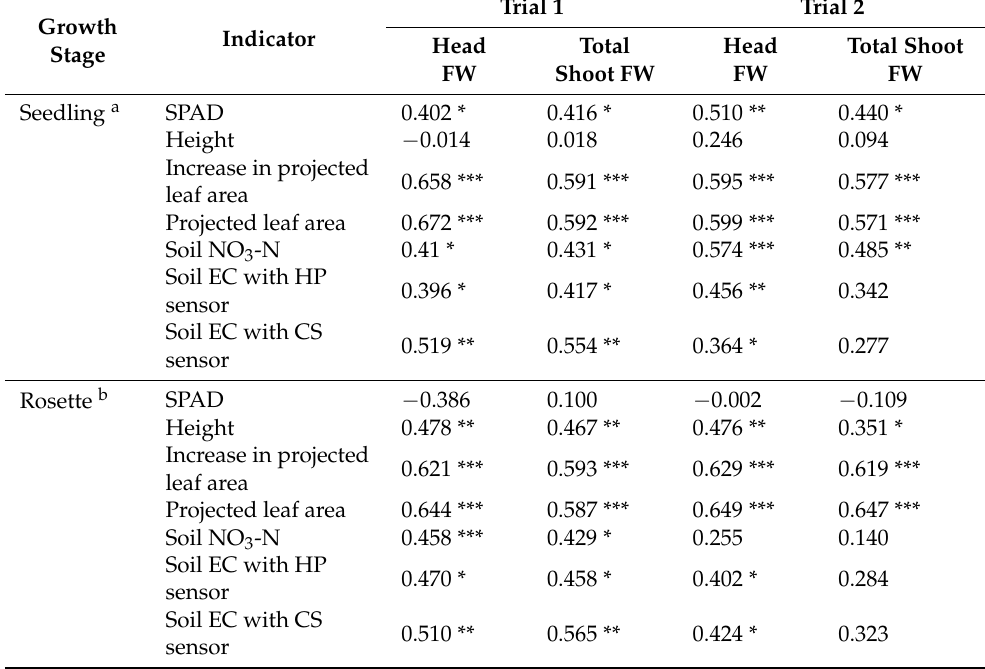
Table 2. Spearman’s rank correlation coefficients of crop and soil indicators during early growth stages with the head and shoot fresh weight at harvest (Trials 1 and 2). Values are the medians of 31 replicates for Trial 1 and 32 replicates for Trial 2. FW, fresh weight.